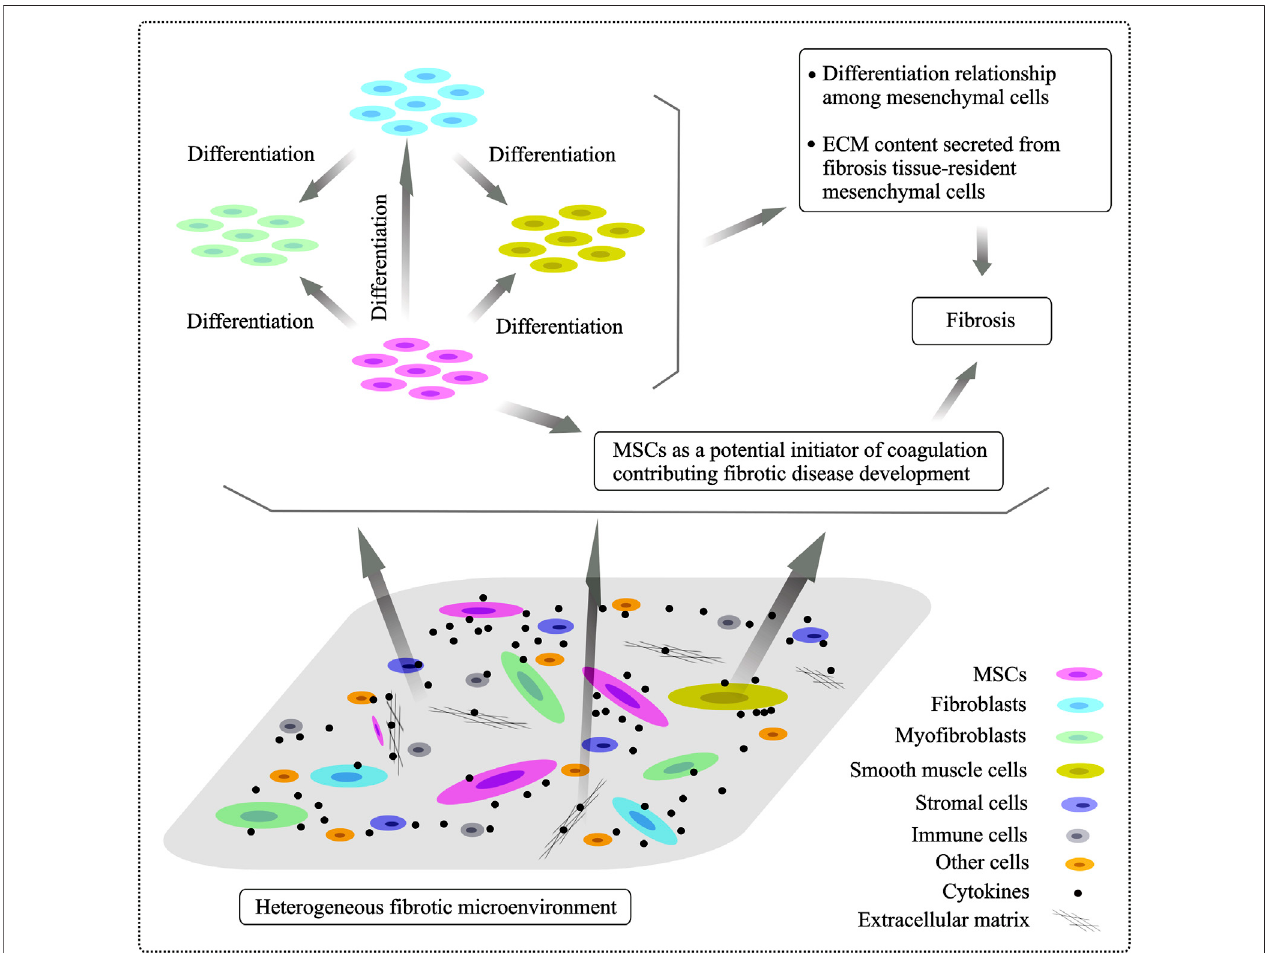
FIGURE 1 | Heterogeneity of fi brogenic cells involved in the fi brogenic processes and differentiation relationship of mesenchymal cells. The fi brotic niche of microenvironment is very heterologous and it is composed of various cellular subpopulations and stromal entities. Resident fi brotic tissue-associated mesenchyme- derived cell types, including fi broblasts, myo fi broblasts, smooth muscle cells and MSCs, are major players in tissue fi brosis development. Transformation relationship among mesenchymal cells localized in the fi brotic tissues is supposed and, specially, MSCs have been shown to undergo differentiation into other mesenchymal cells under different conditions, playing a distinct role in progressive fi